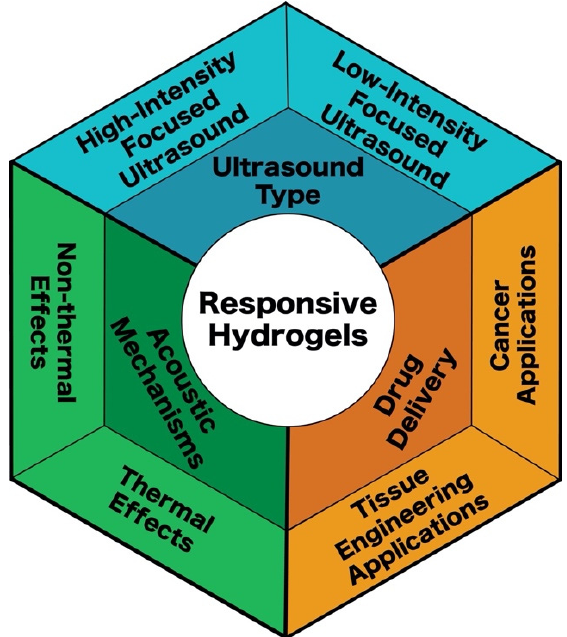
Figure 1. Ultrasound-sensitive hydrogels are designed to respond to ultrasound (either low or high- intensity) via thermal or non-thermal effects. Applications for these drug delivery systems include cancer therapy and tissue engineering.